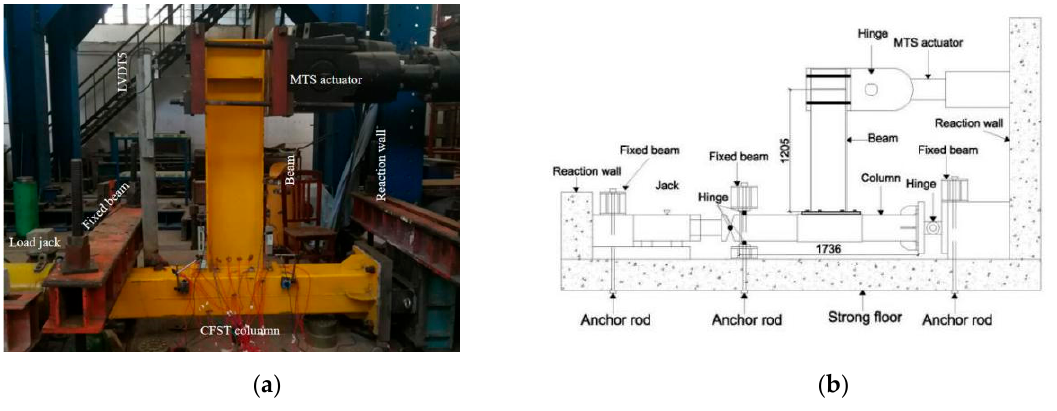
Figure 4. ( a ) A picture; ( b ) Schematic of the test setup.